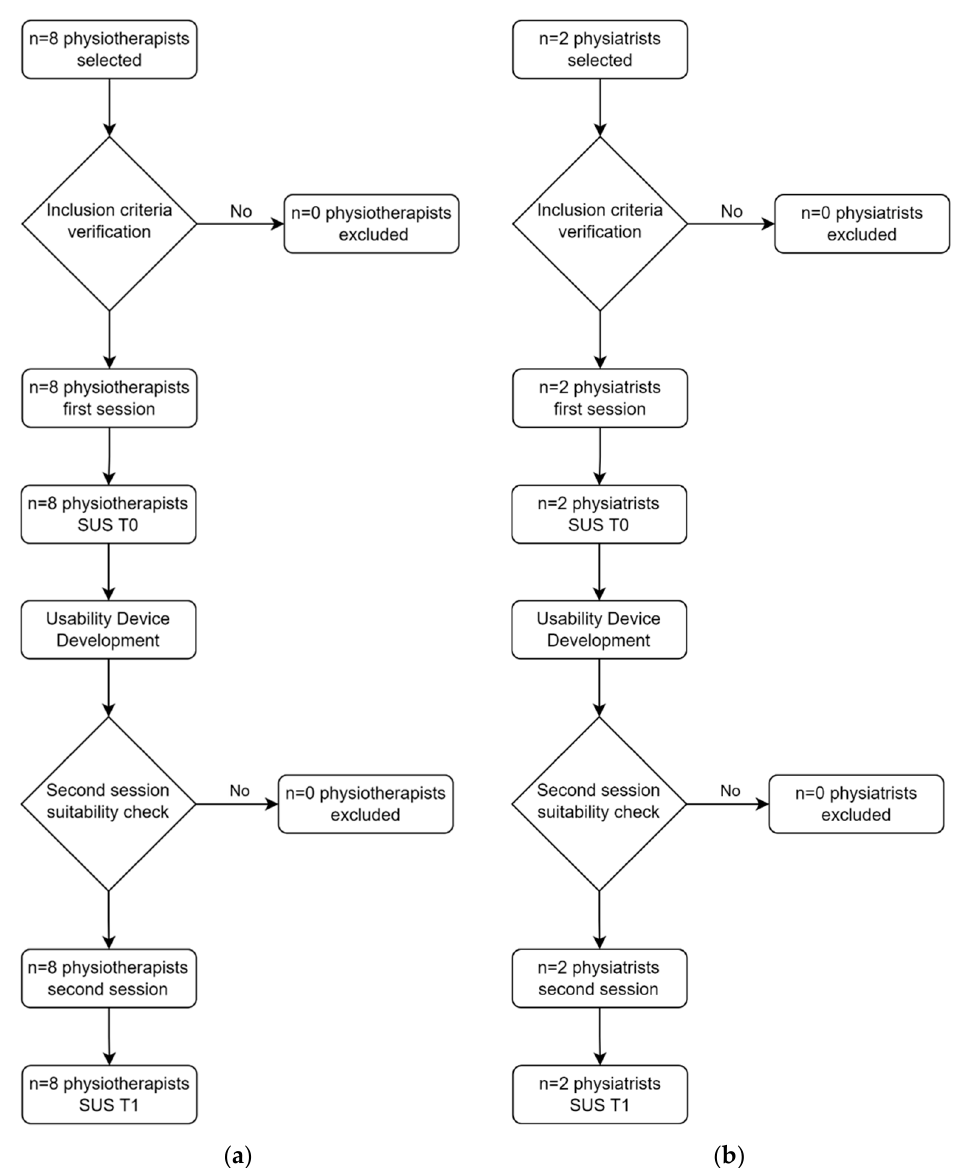
Figure 5. Flowcharts of clinical operators: ( a ) physiotherapists’ flowchart; ( b ) physiatrists’ flowchart.